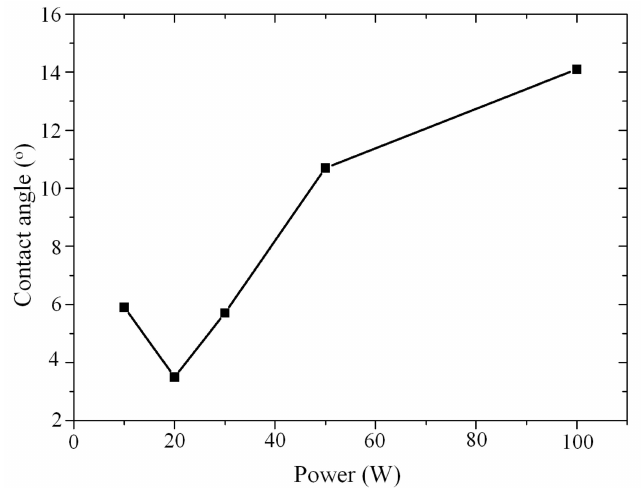
Figure 4. Contact angle versus plasma activation power for a fixed plasma activation time of 60